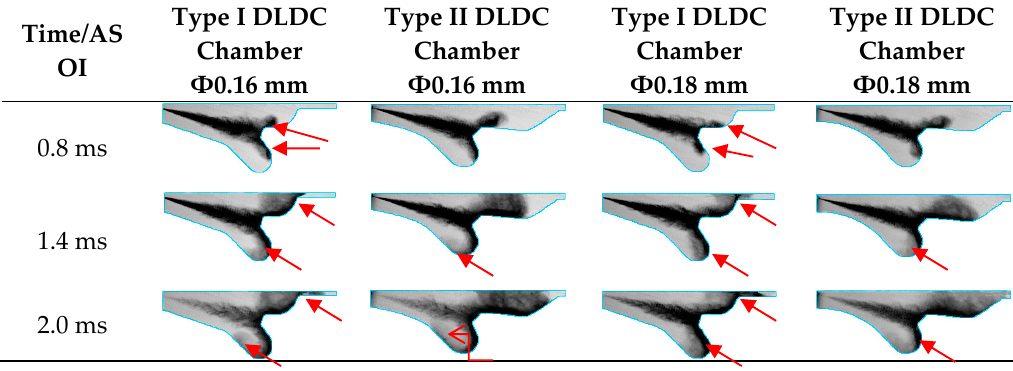
Figure 13. The comparison of fuel spray distributions between the two DLDC chambers with medium load, different nozzles, 150 MPa injection pressure and 5 °CA BTDC injection timing of Mode B.